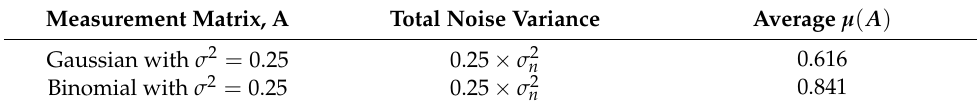
Table 1. Total noise variance and mutual coherence of A, µ ( A ) , with the given properties of A. Measurement Matrix, A